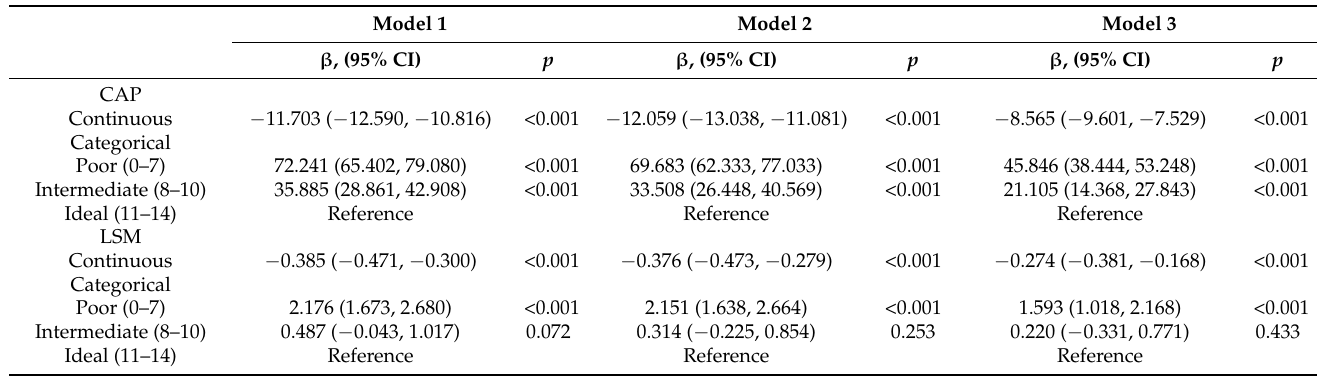
Table 2. Linear regression model between CAP, LSM, and CVH